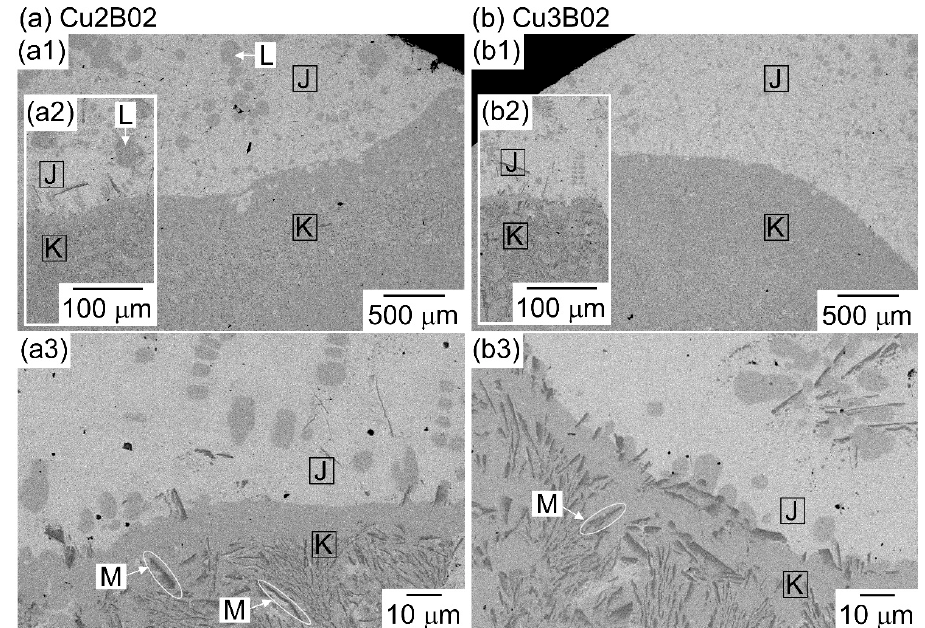
Figure 10. SEM-BSE images of the arc-melted ingots of the B-added CoCrCu x FeMnNiB 0.2 (x = 2, 3) (Cu2B02, Cu3B02) HEAs with a macroscopic phase-separated structure. (a) Cu2B02, (b) Cu3B02, (a2) and (a3) are magnified images of (a1) , and (b2) and (b3) are magnified images of (b1).